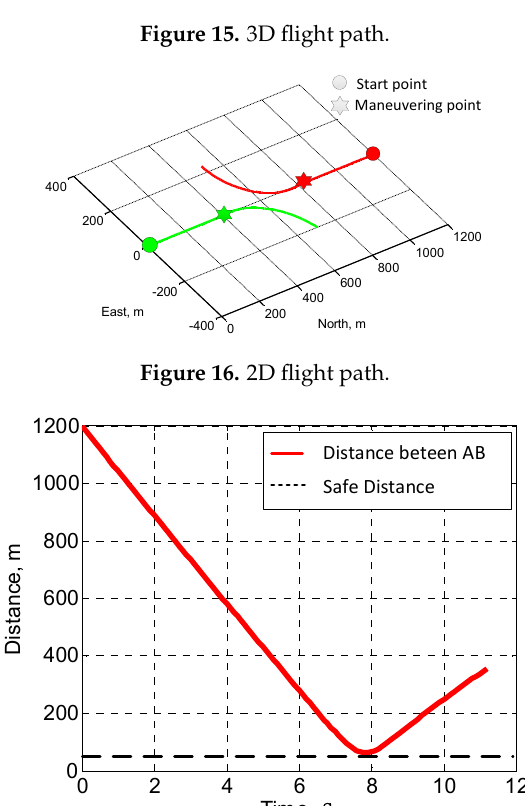
Figure 15. 3D flight path.